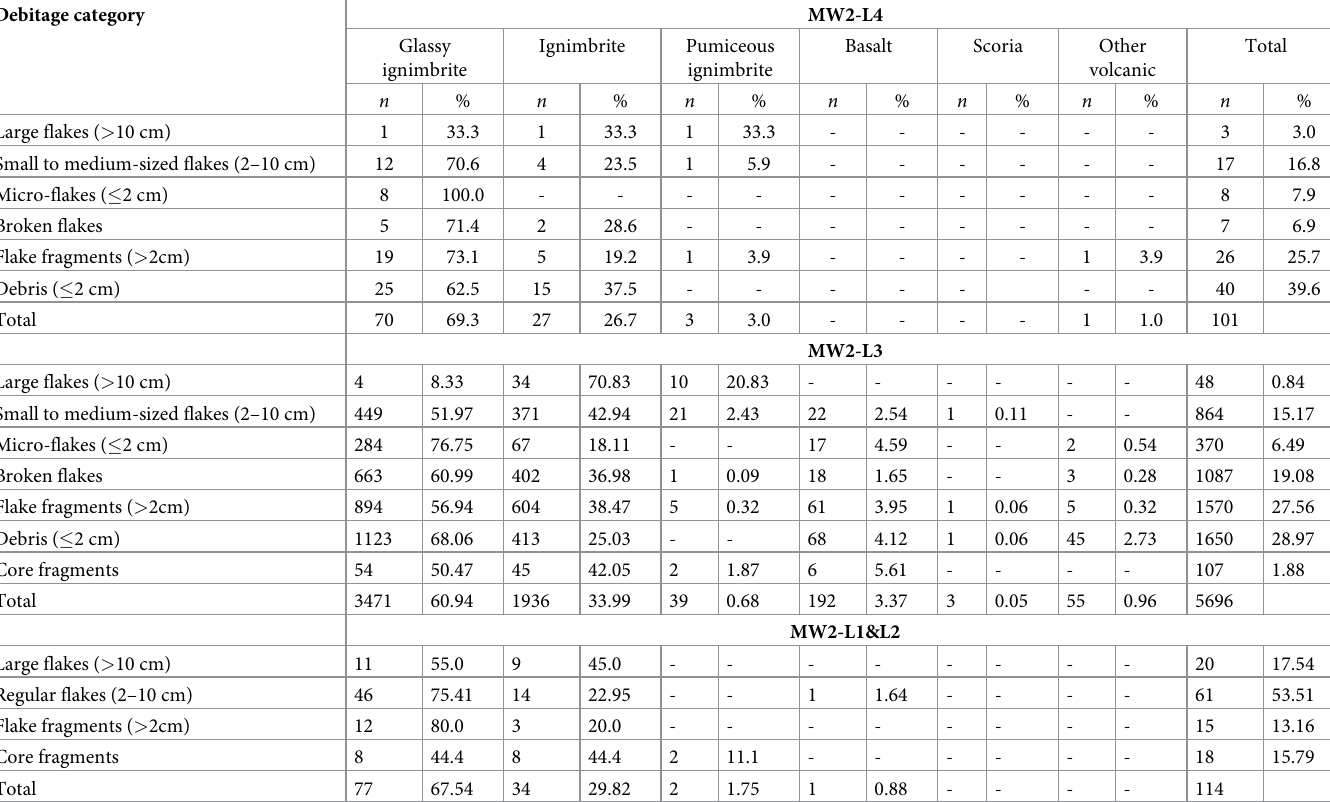
Table 2. Absolute and relative frequencies of debitage breakdown (per raw materials) of MW2 assemblages.